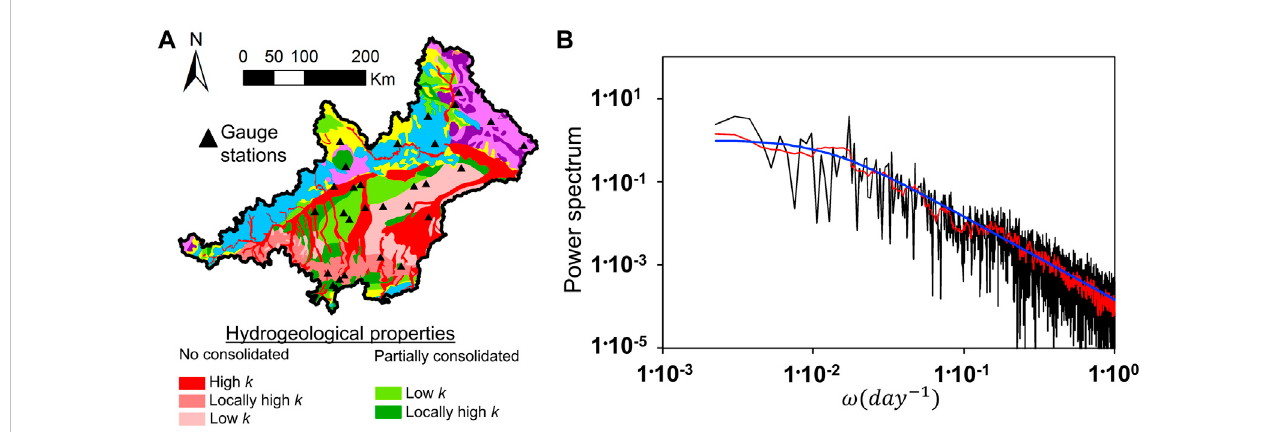
FIGURE 10 (A) Gauging stations whosedata is assessedby means of the spectral analyses. These has been chosen to obtain representative results for materials with different hydrological properties. (B) Example of a the original computed power spectrum (black line) and after a fi ltering process (red line) for the base fl ow measured at one gauge (gauge number 22 in the Supplementary Material) together with the fi tted curve (blue line).